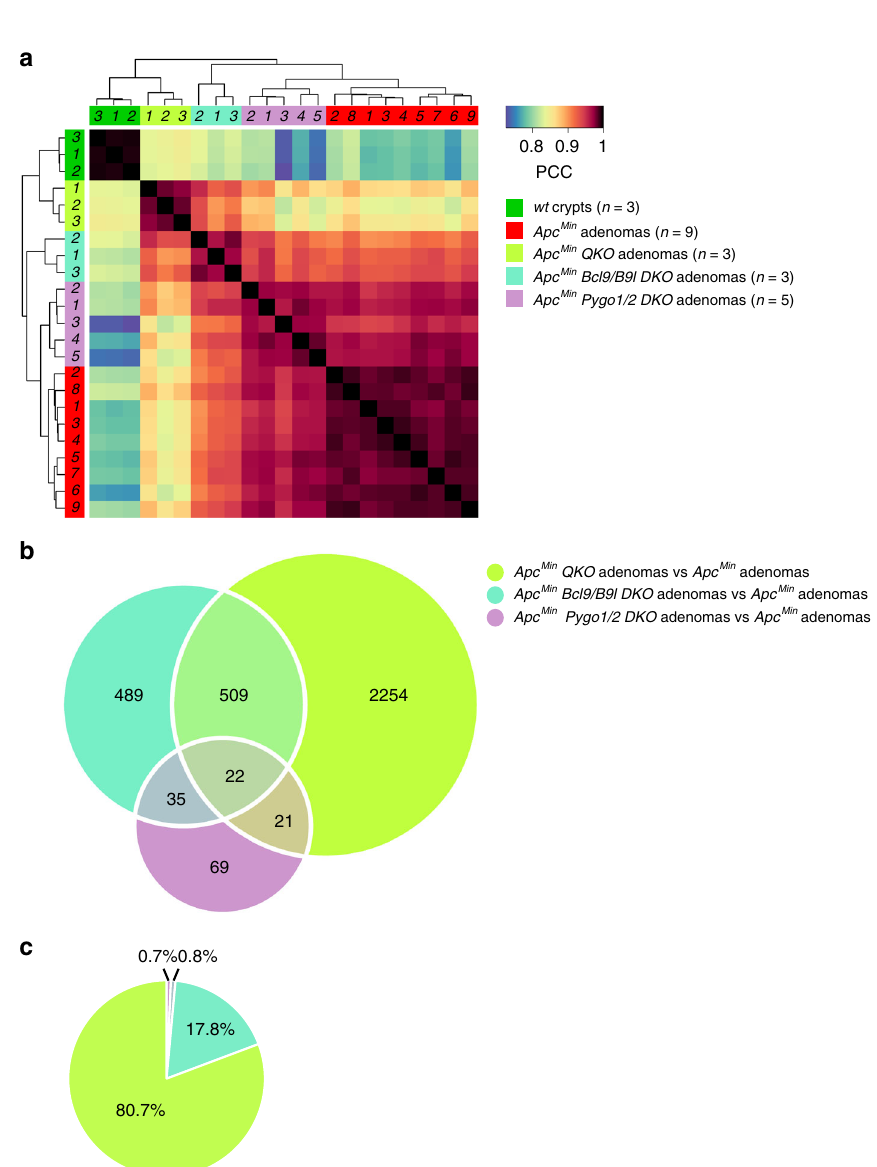
Fig. 3 The gene expression pro fi le of QKO adenomas is determined largely by Bcl9 loss. a Pearson correlation heat-map of gene probe changes of QKO vs control adenomas across all 5 cohorts (see key, for genotypes); PCC, Pearson correlation coef fi cient ( red , high; blue , low). b Venn diagram showing number of gene probe changes in cohorts (individual and shared), as shown in key. c Pie chart showing the unique contribution of genotypes shown in ( b ) to gene probe changes of QKO vs control adenomas. See also Supplementary Figure 7 Notably, APC regulates the junctional pool of β -catenin 42 , and As expected, Apc Min adenoma cells exhibited high levels of complete Apc loss-of-function causes a drastic increase of cytoplasmic and nuclear β -catenin (Fig. 5a, red signal), but low nucleocytoplasmic at the expense of junctional β -catenin 35 . We levels of junctional β -catenin compared to adjacent normal epithelial cells. In contrast, Bcl9/B9l DKO adenoma cells showed thus examined the subcellular distribution of β -catenin in Bcl9 - very little nucleocytoplasmic β -catenin, which explains the low deleted Apc Min adenomas by immuno fl uorescence (IF).